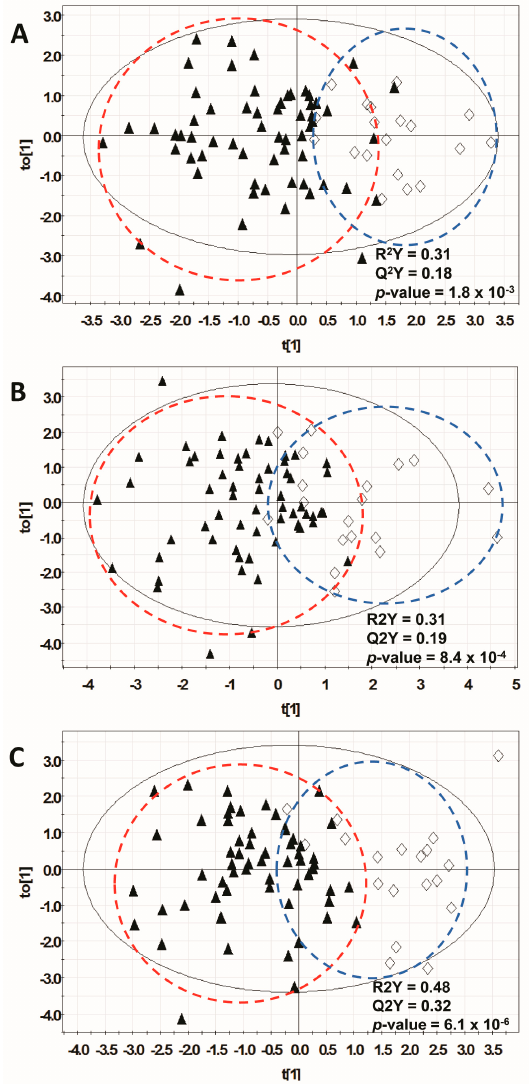
Figure 2. Orthogonal partial least squares discriminant analysis (OPLS-DA) results. Scatter plots showing scores (t) in first (t[1]) and orthogonal (to[1]) components of final OPLS-DA models for one training dataset ( A ) 1 H-NMR; ( B ) GC-MS; ( C ) Combined). Results from other training sets were similar. Plots coded for patient diagnosis: malignant: ▲ vs. benign: ♢ .